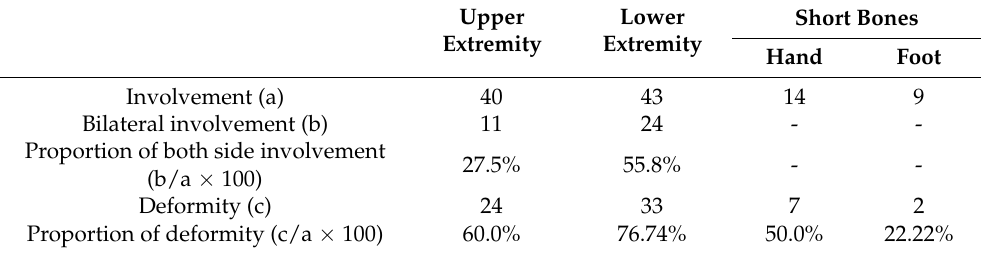
Table 5. Characteristics of deformity in patients.